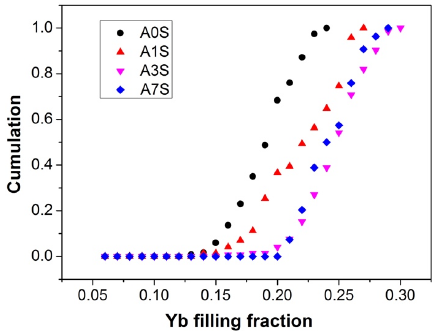
Fig. 8 Accumulation curves of Yb filling fraction for the samples A0S, A1S, A3S, and